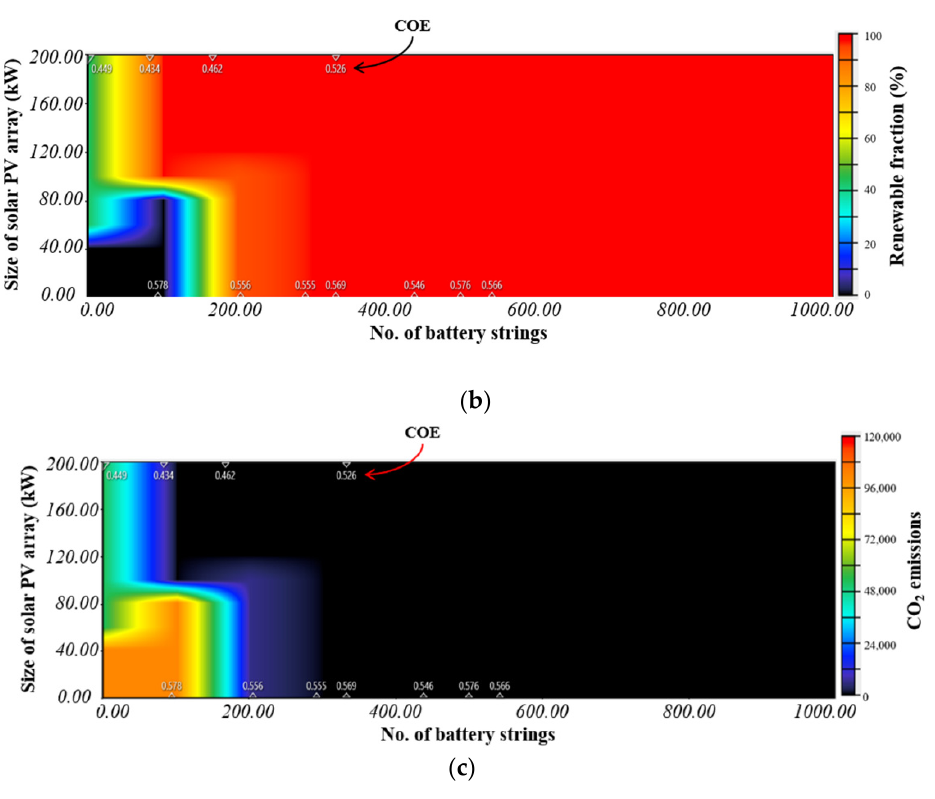
Figure 20. Sensitivity analysis between the size of solar PV array & number of battery strings with variation in ( a ) NPC, ( b ) renewable fraction, and ( c ) CO 2 emissions.